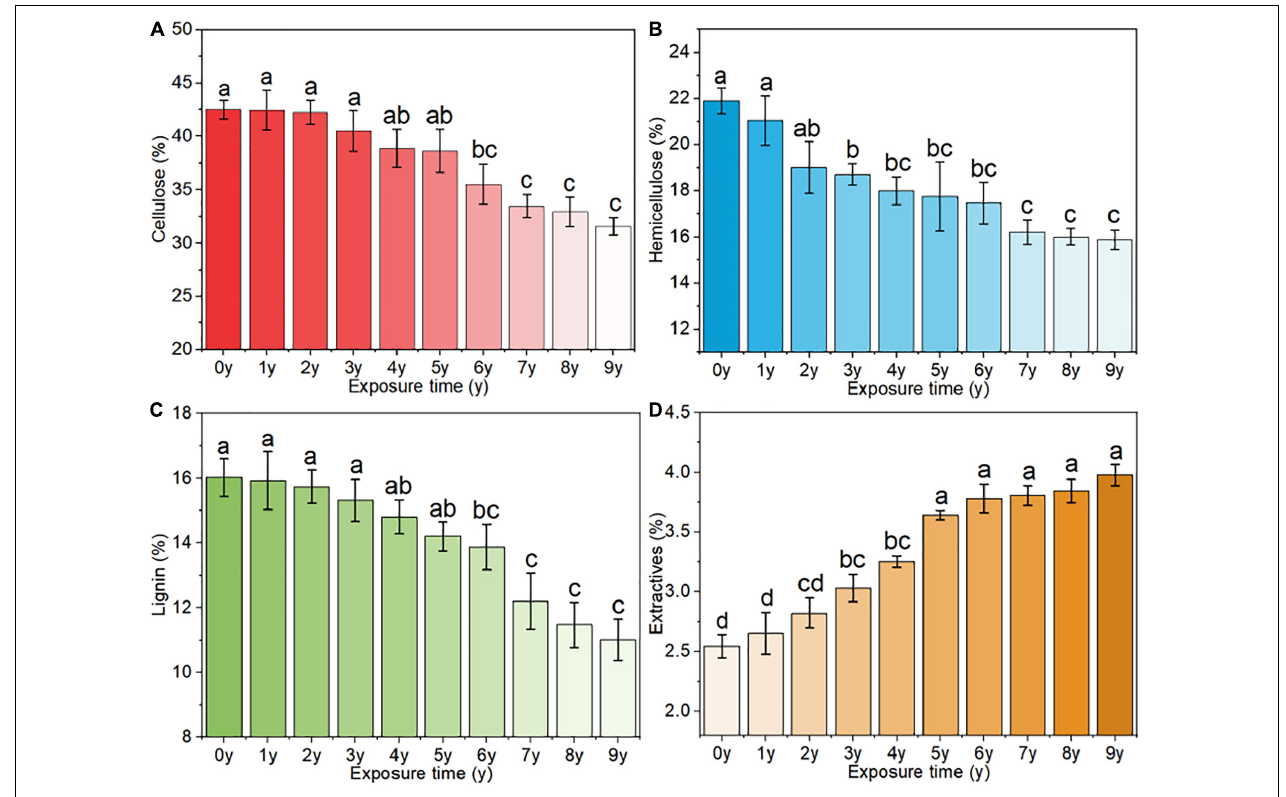
FIGURE 4 | Changes in the main chemical components of the S. psammophila sand barrier, (A) cellulose, (B) hemicellulose, (C) lignin, and (D) extracts.